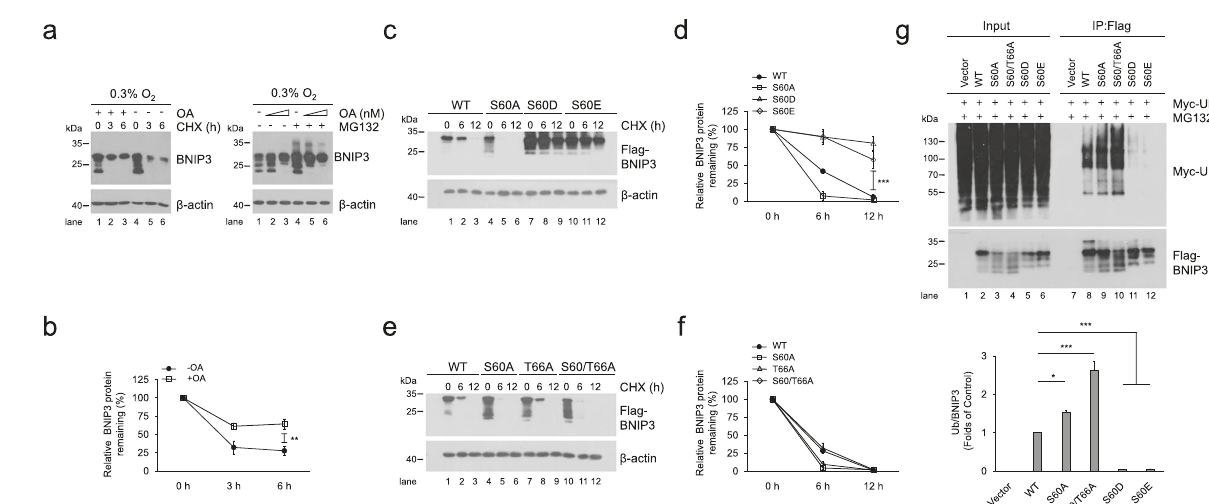
Fig. 3 Phosphorylation of BNIP3 at S60/T66 is essential to improve its stability. a PC12 cells were exposed to 0.3% O 2 supplemented with 200 nM okadaic acid (OA) for 12 h and then treated with 20 μ g ml − 1 cycloheximide (CHX) for the indicated times (left panel) or with 100, 200 nM OA plus 10 μ M MG132 for 6 h (right panel). Cell lysates were detected via western blotting using the indicated antibodies. b Quanti fi cation of degradation rate of BNIP3 in CHX chase experiments shown in ( a ). c – f HeLa cells were transfected with plasmids encoding WT or the indicated BNIP3 mutants for 48 h and then treated with 20 μ g ml − 1 CHX for 0 h, 6 h, or 12 h. BNIP3 expression was detected via western blotting. d and f are quanti fi cation of degradation rate of BNIP3 shown in ( c ) and ( e ), respectively. g HeLa cells were transfected with Myc-Ub and empty vector, WT or the indicated BNIP3 mutant for 48 h and treated with 10 μ M MG132 for 12 h. Cell lysates were boiled and immunoprecipitated with an anti-Flag antibody. The immune complexes were then analyzed via western blotting. n = 3. The data are expressed as means ± SEM. * P < 0.05, ** P < 0.01, *** P < 0.001 versus the indicated